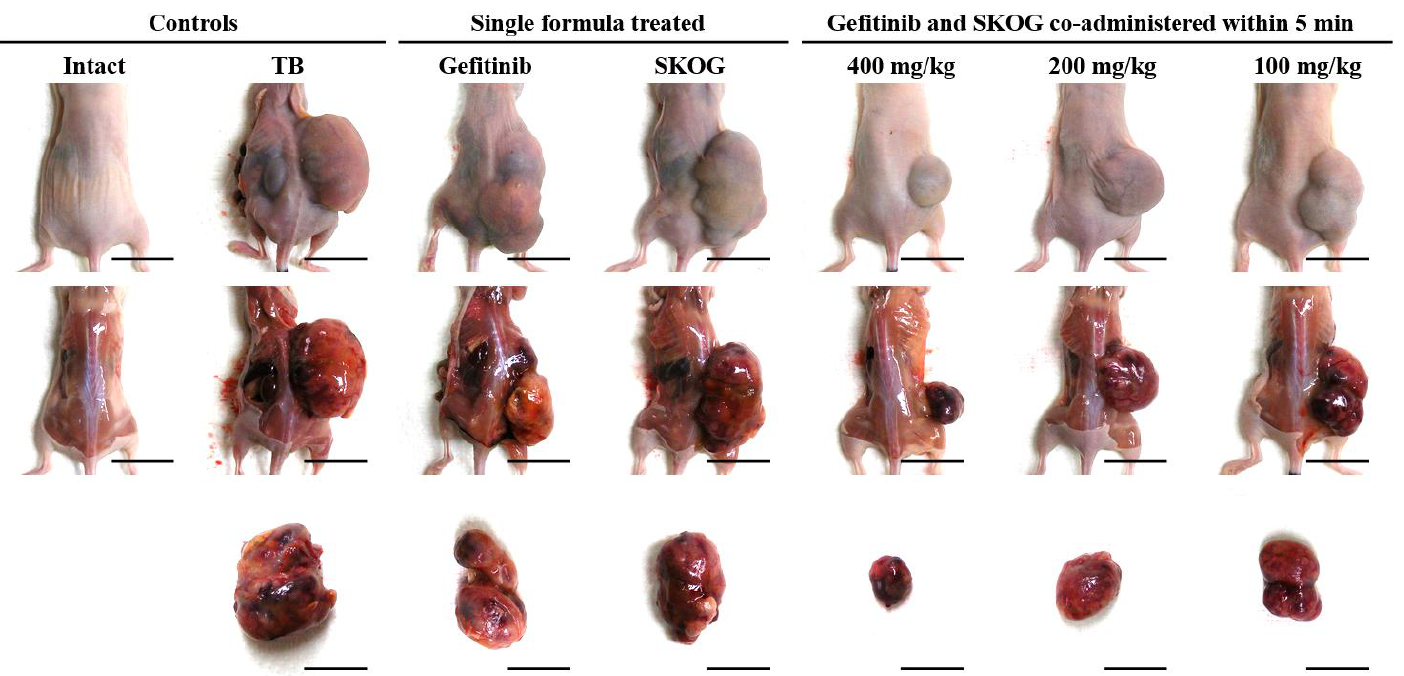
Figure 3. Representative gross tumor mass images of intact or NCI-H520 tumor cell xenograft mice taken at sacrifice. TB = tumor-bearing; AR = Adenophorae Radix; KOG = Kyeongokgo ; SKOG = sasam-Kyeongokgo .